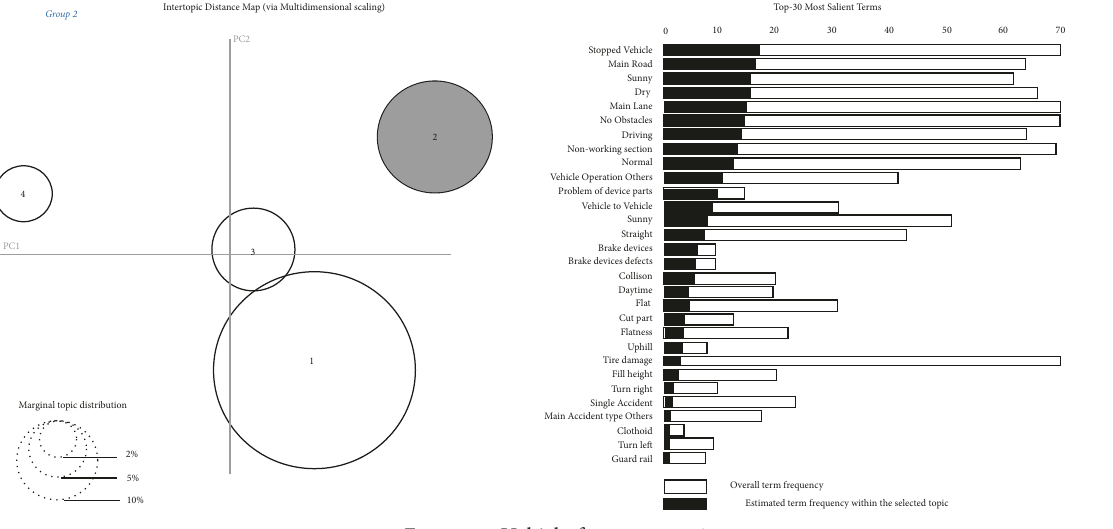
Figure 7: Vehicle factor group 2.